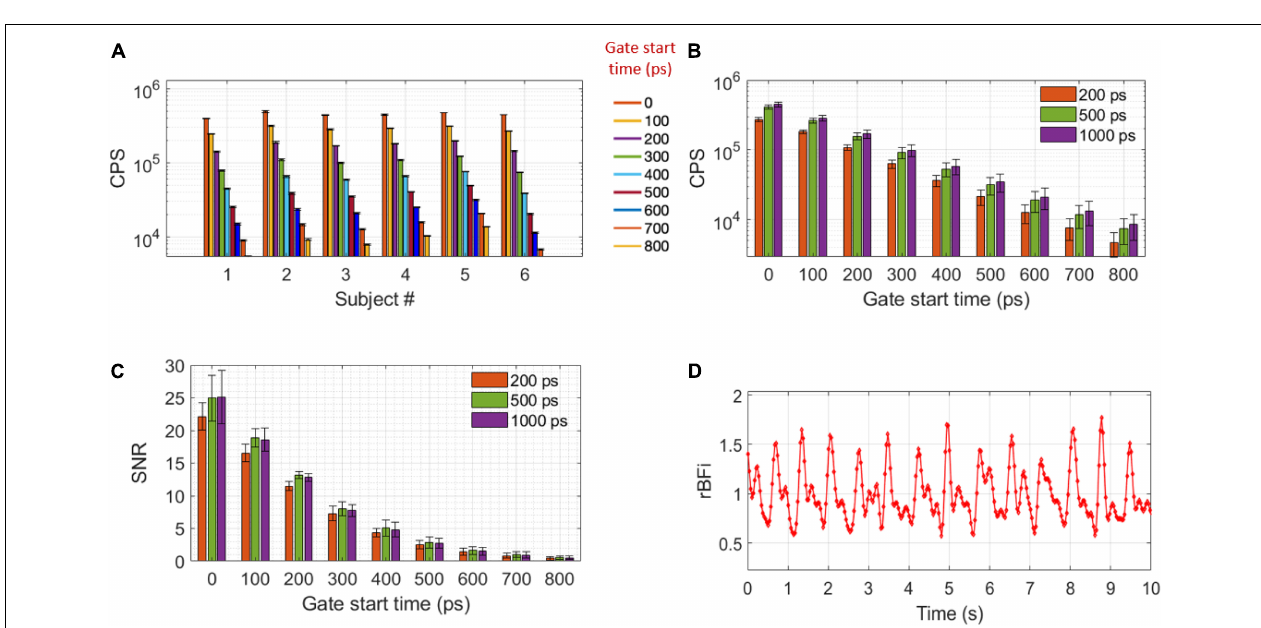
FIGURE 4 | Measurement results with shaped and unshaped pulses for two-layer phantoms. (A) The electric field autocorrelation function g 1 , for different thicknesses of the top layer in the two-layer phantom while the laser was unshaped and (B) shaped at very late gate start time and 1 ns gate width. (C) The min-max normalized rD b as a function of the different thicknesses (error bars are stdev).